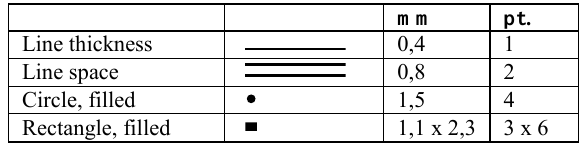
Table 3. Graphic minimum dimension and distance with respect to displays (Lechthaler and Stadler, 2006) If smaller scales are used, relevant objects and